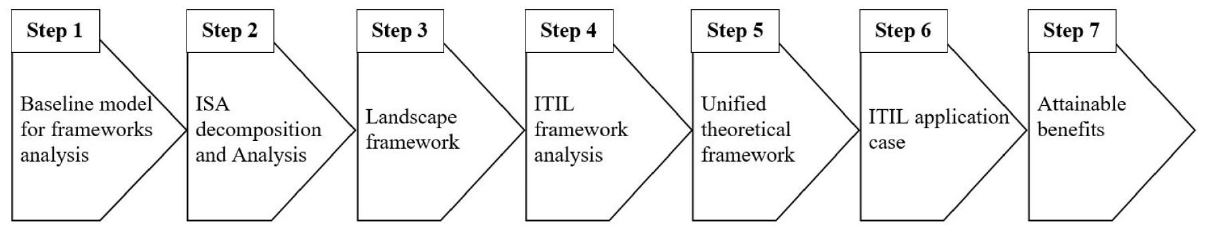
Figure 2. Research